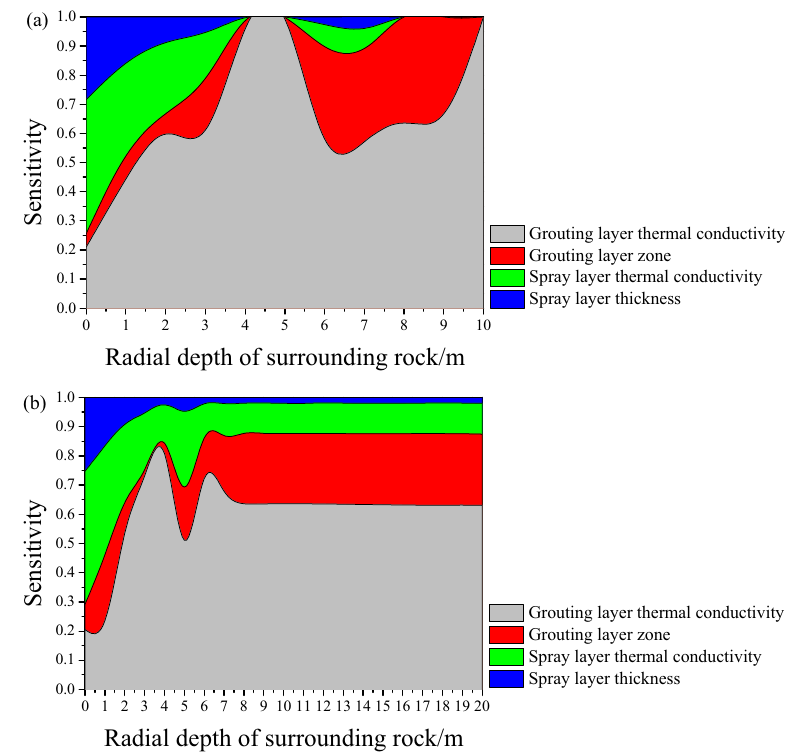
Figure 22: Sensitivities of different influencing factors to temperature field distribution of the surrounding rock: ( a ) 30 days; ( b ) 1,095